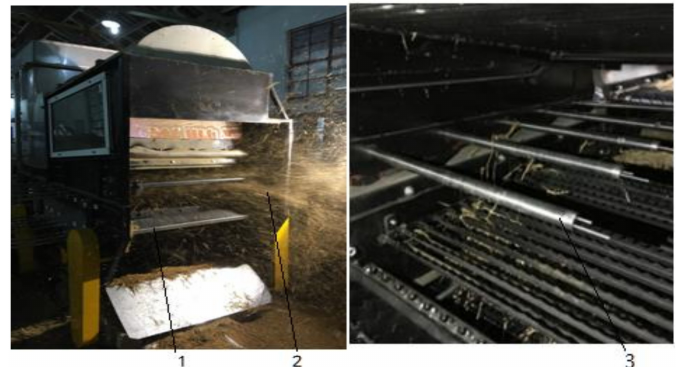
Figure 5. Cleaning material acquire process for testing the performance of the controller, 1. Grain sieve loss sensor, 2. Residual flow, 3.